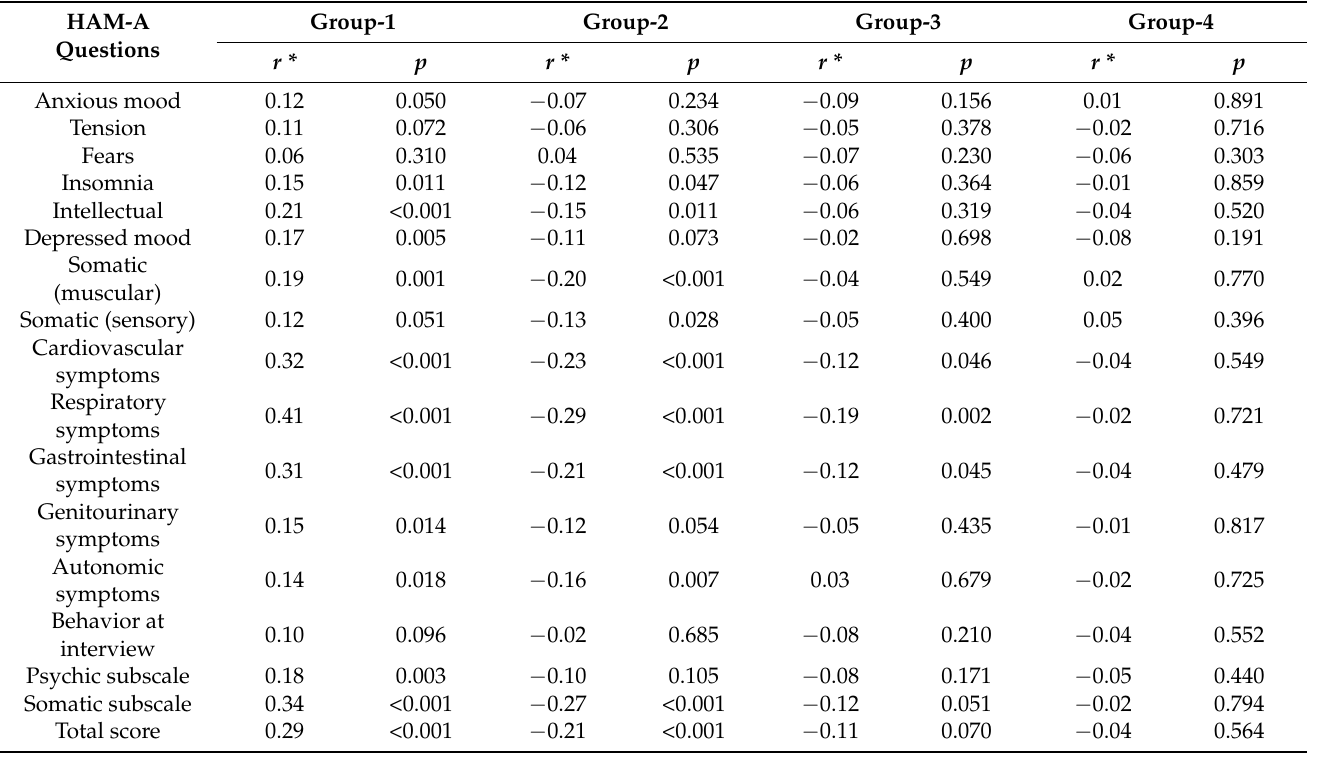
Table 4. Correlation between HAM-A questions and different